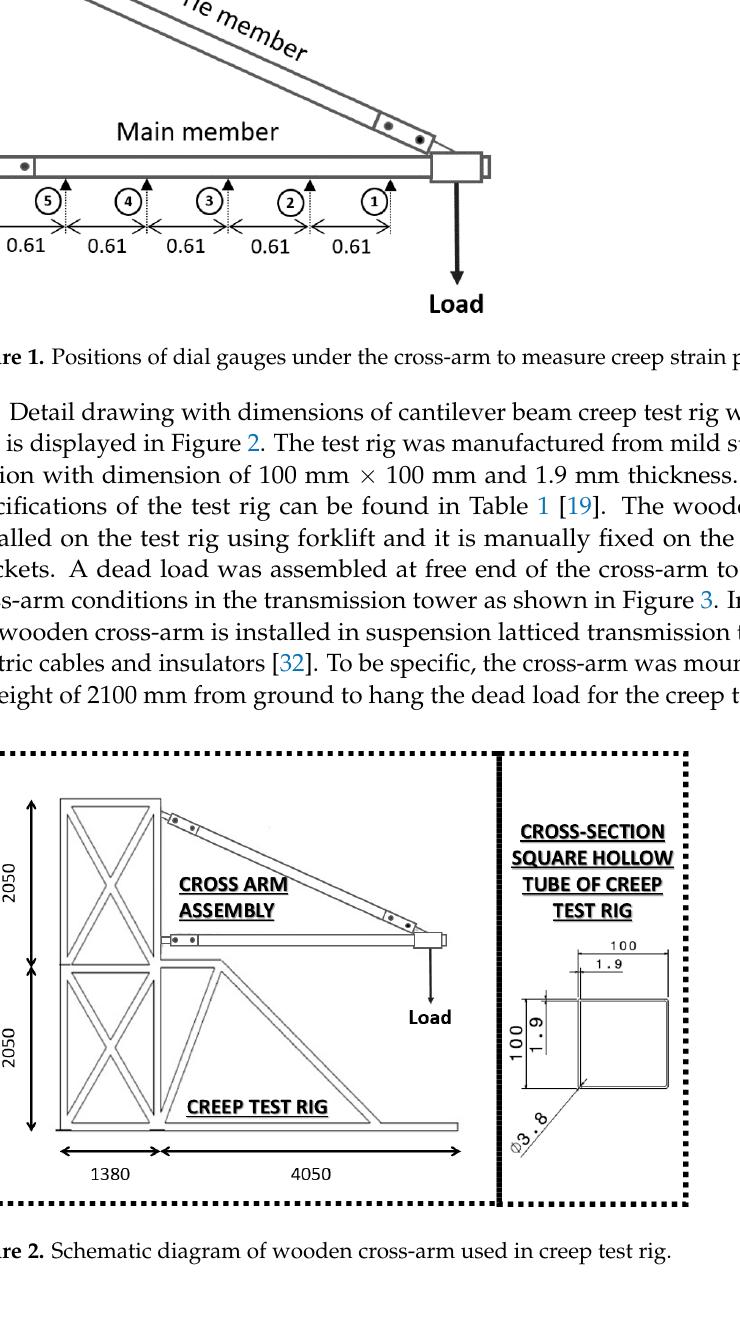
Figure 3. Dimension of latticed transmission tower. Adapted with permission from IEEE, 2021 [33] The geometry and dimensions of latticed transmission tower is shown in Figure 3 [33]. The steel tower and wooden cross-arm was connected using specialised fittings. The assemblymen of wooden cross-arm to steel tower is manually fixed by bolt and nut. Based on Figure 4, the cross-arm was attached to the steel tower by sandwiching two steel plate fittings with end cross-arm member and they are manually connected by using bolt and nut.